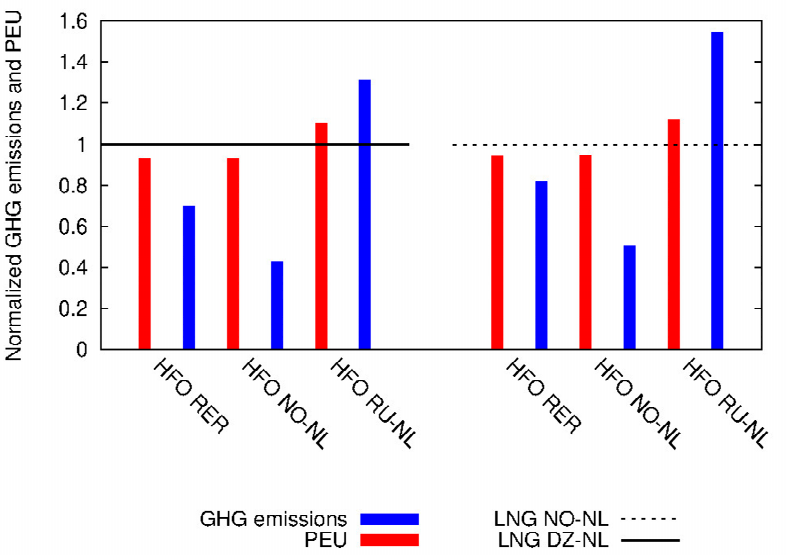
Figure 3. Cradle-to-tank GHG emissions and PEU per MJ fuel at the bunker station.